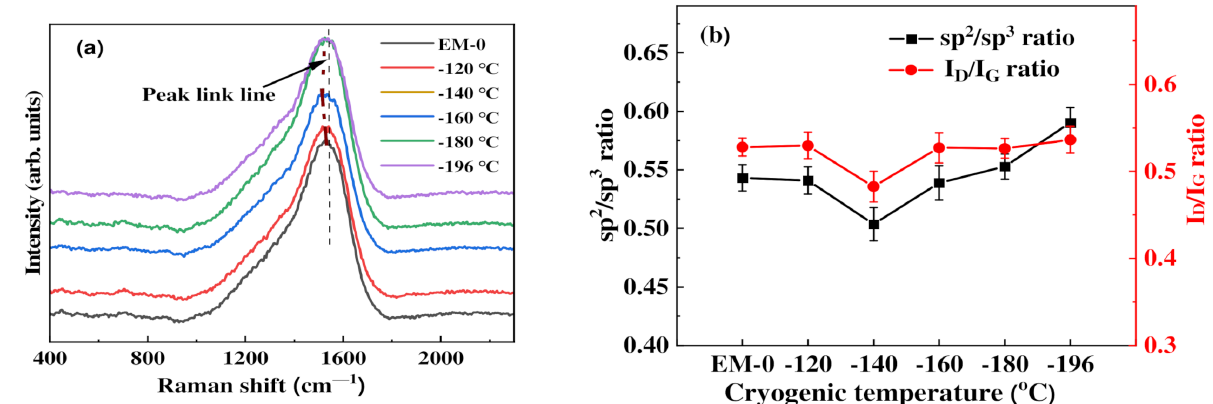
Figure 4. Raman spectra ( a ), I D /I G and sp 2 /sp 3 bond ratios ( b ) of specimens with the cryogenic